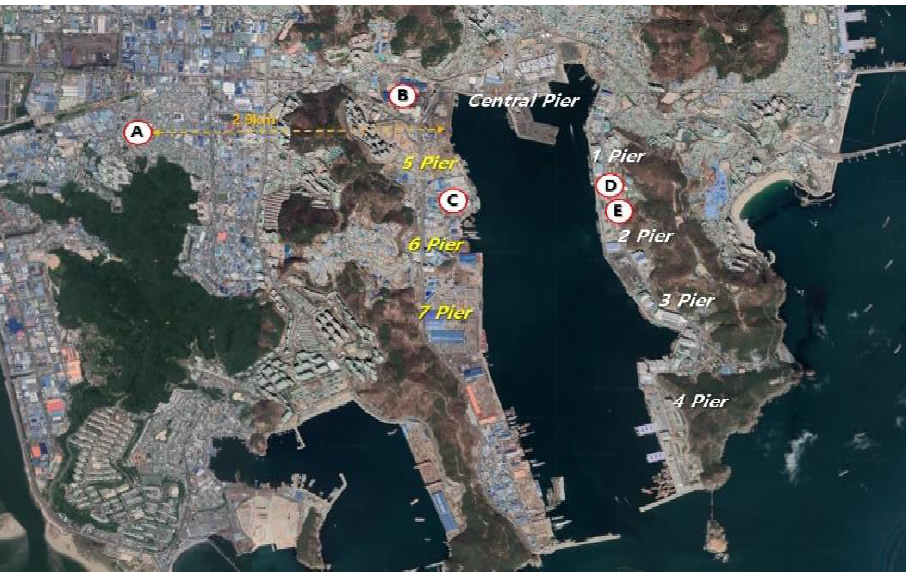
Figure 4. Industrial Factory Distribution near Gamcheon Port.